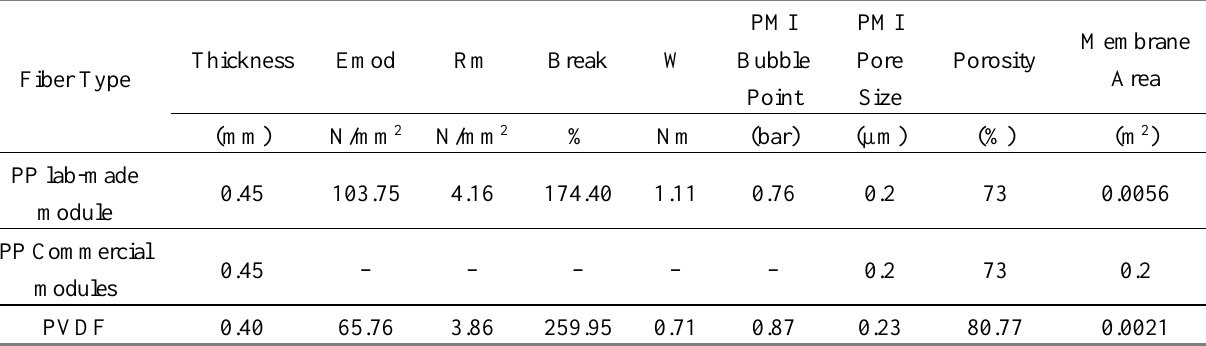
Table 1. Main properties of membrane applied in current study.